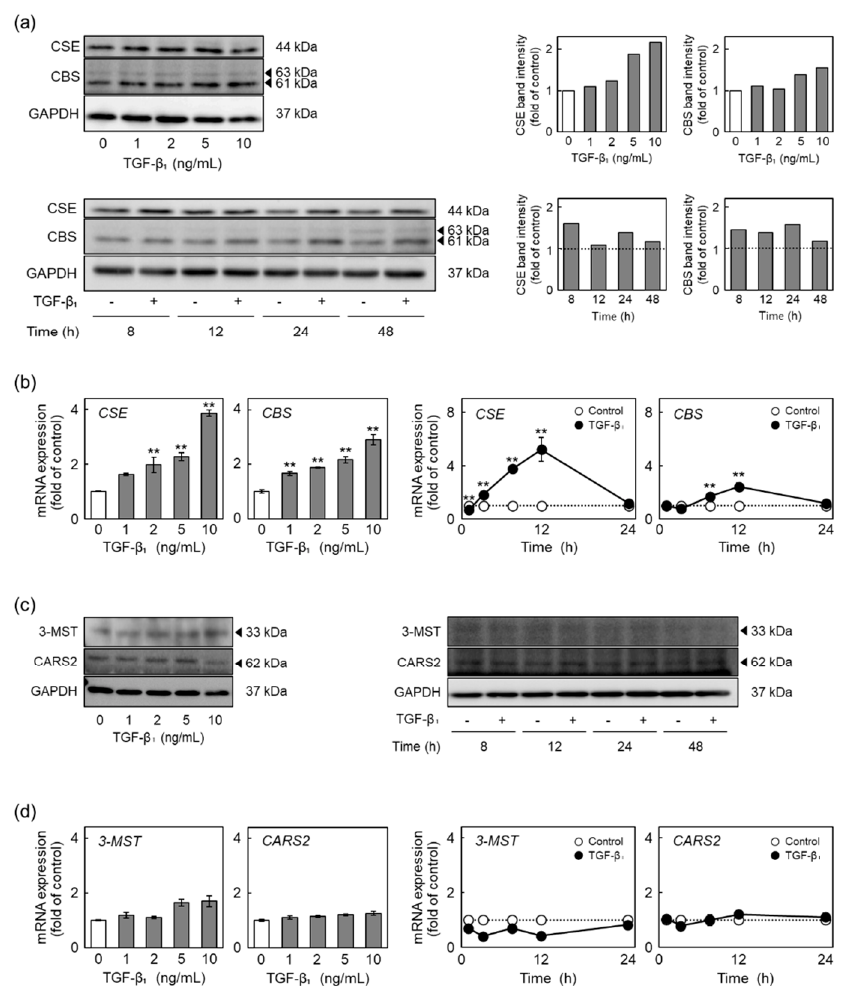
Figure 3. Effects of TGF- β 1 on the expression of RSS-producing enzymes in vascular endothelial cells. ( a ) Levels of CSE and CBS proteins in vascular endothelial cells treated with TGF- β 1 . Confluent cultures of vascular endothelial cells were treated with TGF- β 1 (1, 2, 5, or 10 ng/mL) for 24 h (upper panels) or treated with TGF- β 1 (10 ng/mL) for 8, 12, 24, or 48 h (lower panels). The arrowheads indicate the corresponding protein. Quantification of band intensities of CSE and CBS (right panels). The data are representative of two independent experiments. ( b ) Expression of CSE and CBS mRNAs in vascular endothelial cells treated with TGF- β 1 . Confluent cultures of vascular endothelial cells were treated with TGF- β 1 (1, 2, 5, or 10 ng/mL) for 12 h (left panels) or treated with TGF- β 1 (10 ng/mL) for 2, 4, 8, 12, or 24 h (right panels). ( c ) Levels of 3-MST and CARS2 proteins in vascular endothelial cells treated with TGF- β 1 . Confluent cultures of vascular endothelial cells were treated with TGF- β 1 (1, 2, 5, or 10 ng/mL) for 24 h (left panel) or treated with TGF- β 1 (10 ng/mL) for 8, 12, 24, or 48 h (right panel). The arrowheads indicate the corresponding protein. The data are representative of two independent experiments. ( d ) Expression of 3-MST and CARS2 mRNAs in vascular endothelial cells treated with TGF- β 1. Confluent cultures of vascular endothelial cells were treated with TGF- β 1 (1, 2, 5, or 10 ng/mL) for 12 h (left panels) or treated with TGF- β 1 (10 ng/mL) for 2, 4, 8, 12, or 24 h (right panels). Values are the mean ± S.E. of three independent samples in Figure 3b,d. The data were analyzed using one-way ANOVA, followed by Dunnett’s test (Figure 3b,d, left panels) or Student’s t -test (Figure 3b,d, right panels). ** Significantly different from the corresponding control, p <